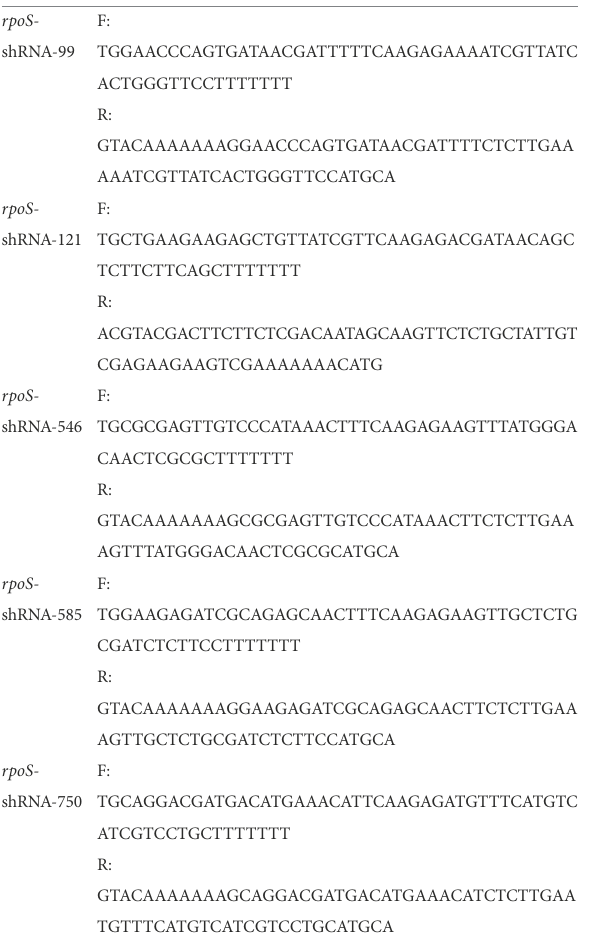
TABLE 1 Oligonucleotides used in producing shRNA for stable gene silencing. Target shRNA sequence for stable gene silence (5 ′ -3 ′ ) gene